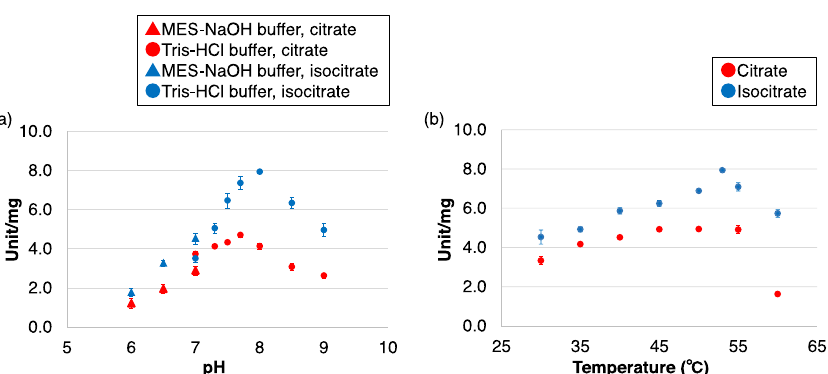
Figure 2. Optimal pH and temperature for Sy AcnB. ( a ) Effect of pH on Sy AcnB activity. The experiment was performed using 50 pmol of Sy AcnB. The red circles and triangles represent the specific activity for citrate at 45 °C. The blue circles and triangles represent the specific activity for isocitrate at 53 °C. Mean ± SD values were calculated from three independent experiments. ( b ) Effect of temperature on Sy AcnB activity. This was measured in Tris–HCl buffer pH 8.0. Mean ± SD values were calculated from three independent experiments. Sy AcnB, Synechocystis sp. PCC 6803 aconitase B; SD, standard